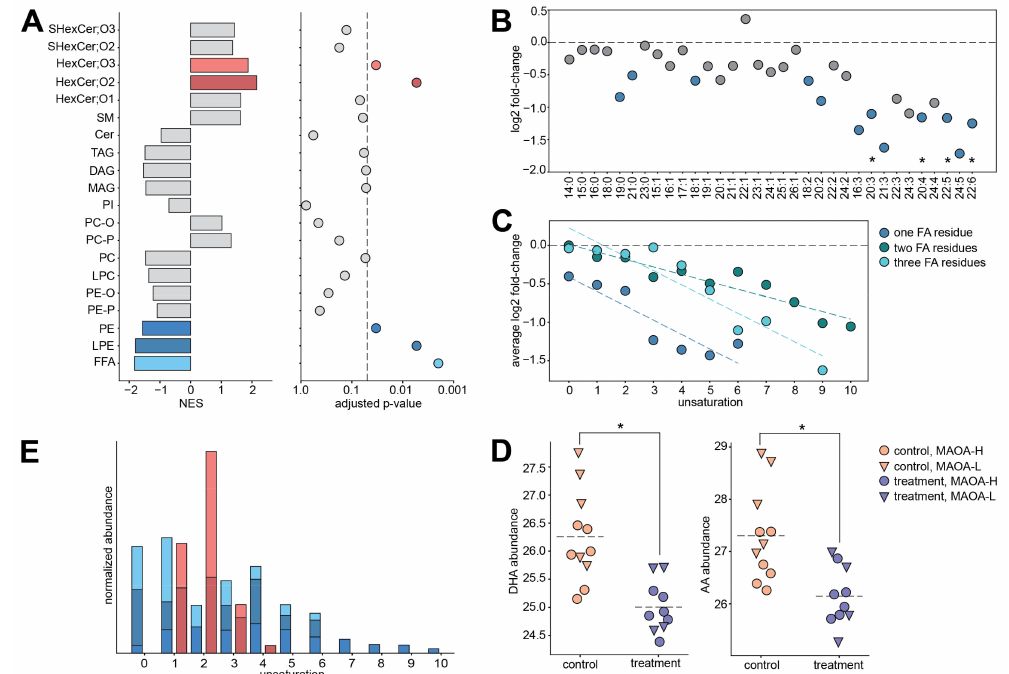
Figure 2. ( A ) Lipid class enrichment analysis results based on the comparison between treated and control animals. Left: normalized enrichment scores (NES). Positive NES corresponds to an increase in the lipid abundances in treated animals, and negative NES corresponds to decrease. Colors mark lipid classes demonstrating significant enrichment in the treatment- control differences. Right: adjusted enrichment p -values. The dashed line corresponds to the adjusted p -value cutoff of 0.05. ( B ) Base two log-transformed fold change (log2 FC) values calculated between treated and control animals for lipids in free fatty acid (FFA) class. X -axis labels indicate fatty acid chain length and number of double bonds. FFAs are ordered by increasing unsaturation. Blue symbols mark compounds with nominal t -test p < 0.05. Asterisks mark statistically significant compounds ( t -test; FDR = 10%, permutations p = 0.0008). The dashed line indicates log2 FC = 0. ( C ) Log2 FC values calculated between treated and control animals, averaged for all the lipids with the same level of unsaturation (number of double bonds). Lipids were first separated into groups based on the number of fatty acid residues, one (dark blue), two (green), or three (light blue), and sphingolipids were excluded. The black dashed line indicates log2 FC = 0. Colored dashed lines indicate linear regression lines fitted to each group ( p = 0.0054, 0.54 × 10 − 5 and 0.00022 for lipid classes containing one, two and three fatty acid residues, respectively). ( D ) Abundance levels of docosahexaenoic acid (DHA) and arachidonic acid (AA) in treated and control animals. Symbols represent individual samples. Colors correspond to treatment status, shapes to the MAOA genotype. Asterisks mark statistically significant differences between treatment and control ( t -test; FDR = 10%, permutations p = 0.0008). ( E ) The cumulative abundances of lipids contained in FFA, LPE, PE, HexCer;O2, and HexCer;O3 lipid classes (colors as in panel A) for each level of unsaturation (number of double bonds per compound). Cumulative abundances were normalized between the lipid